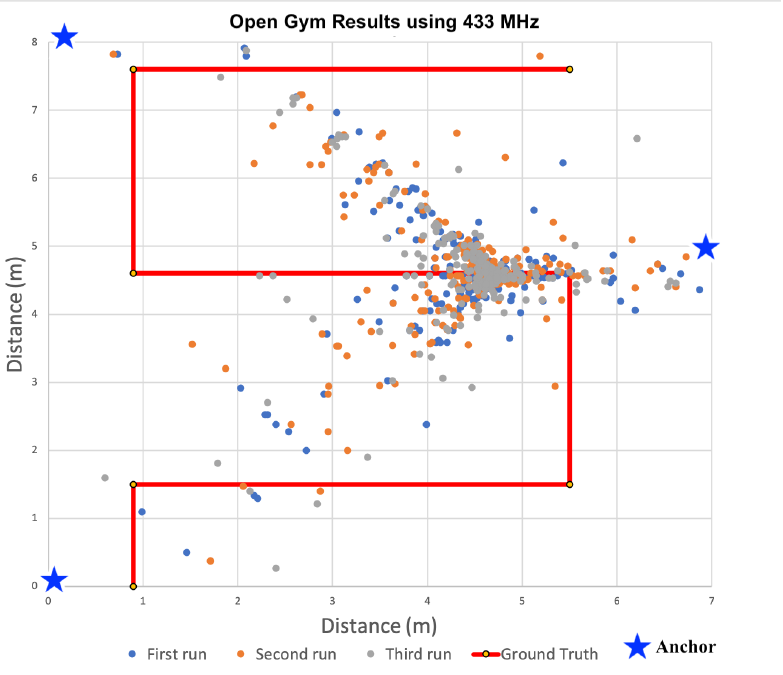
Figure 9. Position estimates obtained using RSS-based localization with 433 MHz transceivers in the University gymnasium. Reference anchor locations used for localization are shown as stars and the solid red line constitutes the ground truth path. The different colored points show the calculated positions while traversing open gymnasium space during multiple successive